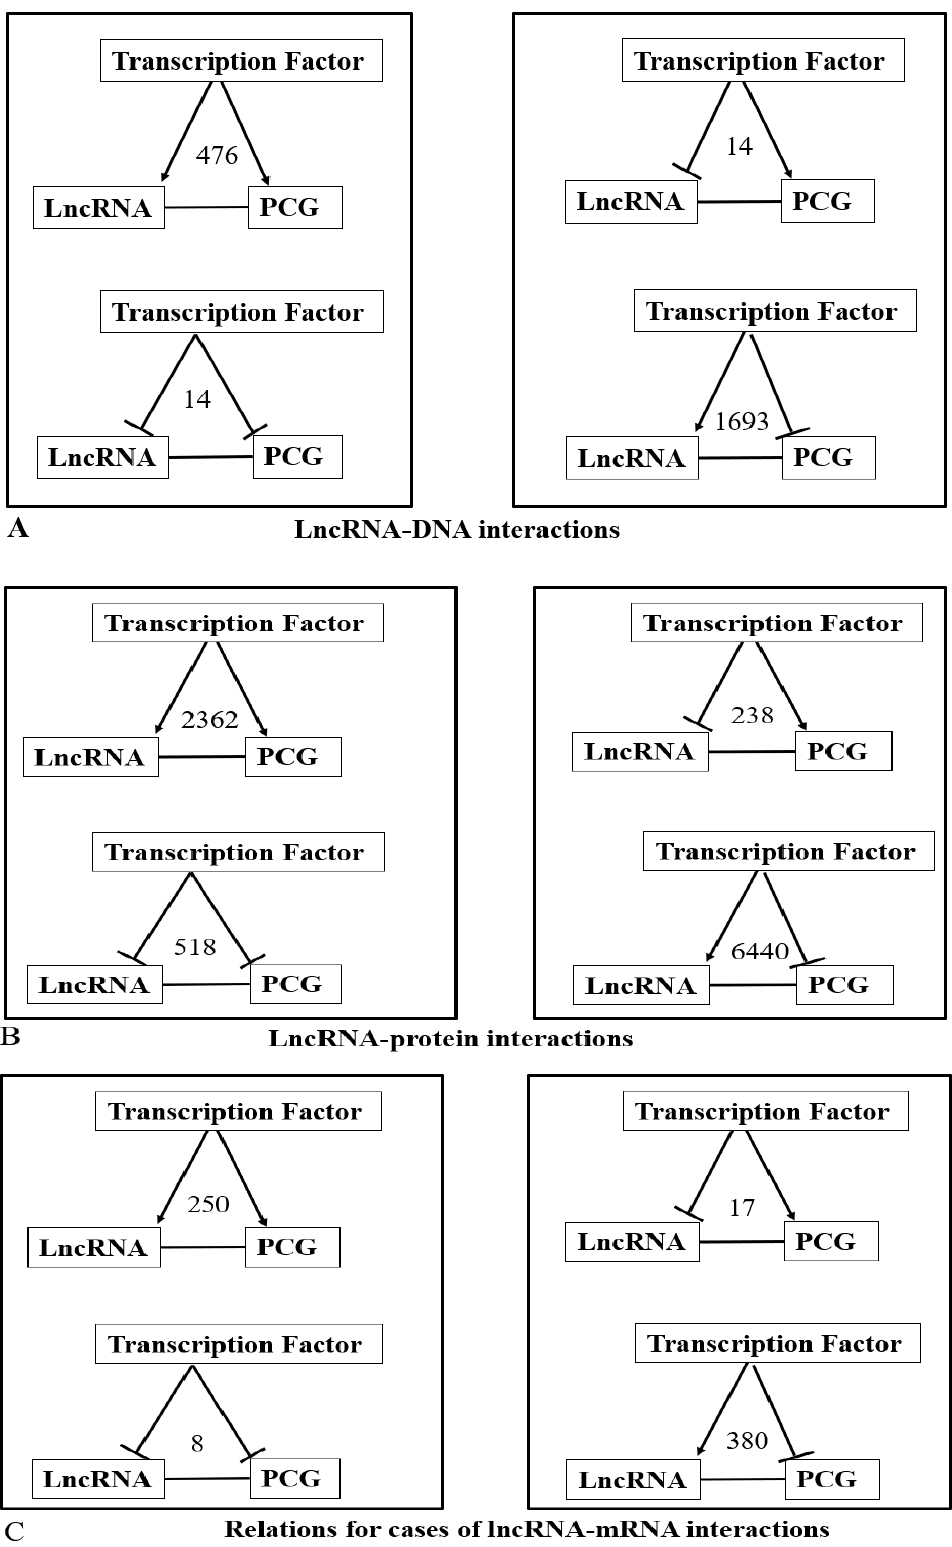
Figure 12. Relation of TF-lncRNA-PCG for lncRNA-DNA, lncRNA-protein and lncRNA-mRNA. Arrow represents activation, line with a vertical line ( ) represents the repression of the target by TF and the horizontal lines represent interaction. Numbers represent the total relations in each category. ( A – C ) represent lncRNA-DNA, lncRNA-Protein and lncRNA-mRNA interactions respec- tively.